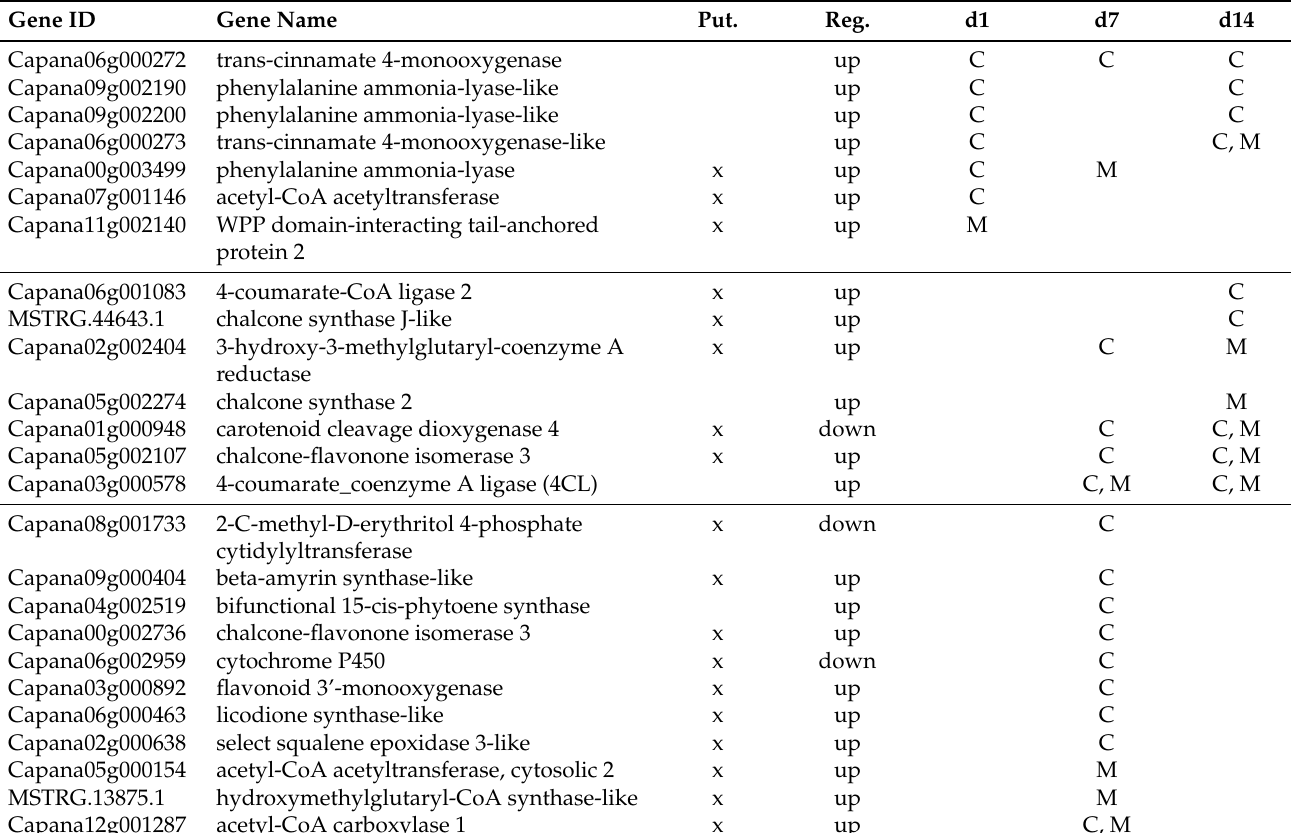
Table 3. (Putative) Annotation of genes detected by the network analysis of all six investigated groups. Sequences of the detected genes from the secondary metabolism were used to perform a BLAST analysis. A putative annotation is indicated in the column ‘Put.’. The induction (up) or repression (down) of the gene at the respective harvest time point is indicated in column ‘Reg.’. Harvest time points are indicated as d1, d7 and d14. Capsicum species are specified as C—chili CAP1035, and M—cultivated pepper